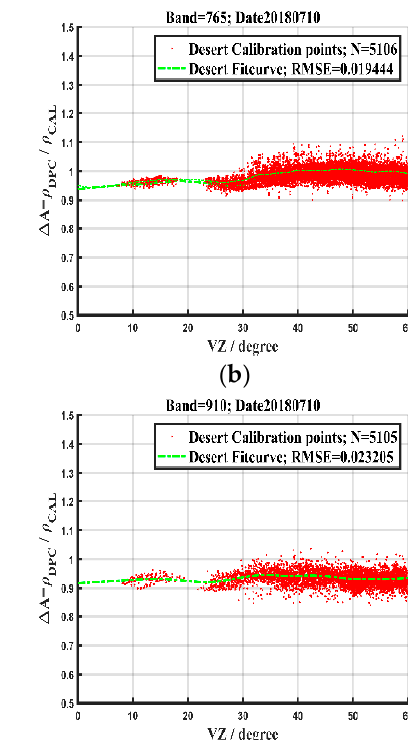
Table 2. The deviation factor of the DPC calibrated by the LNES at different view zenith angles for several NIR bands.